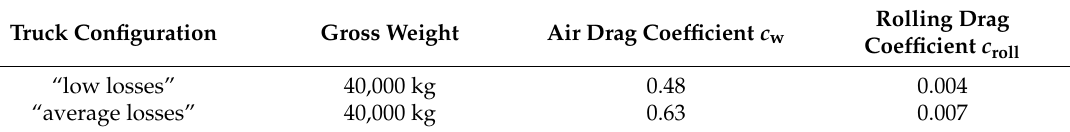
Table 1. The main vehicle parameters used for the following simulations.